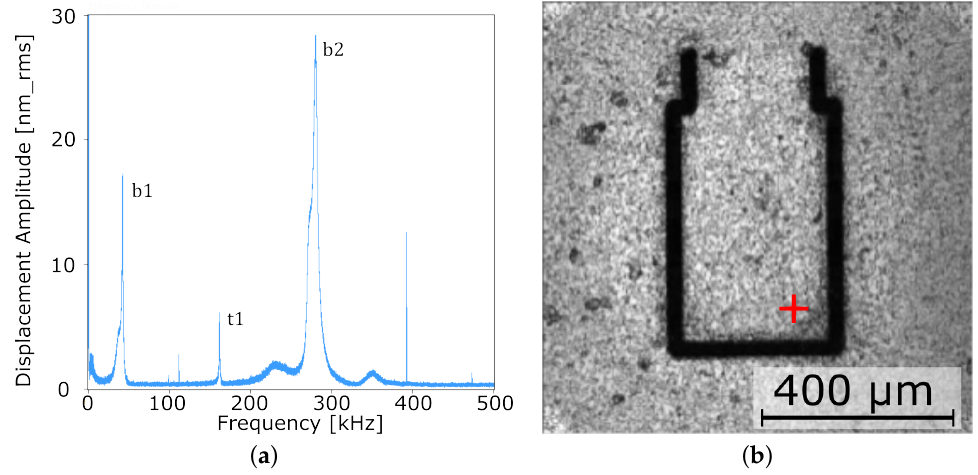
Figure 8. ( a ) Vibrational response of the micro cantilever measured at the location indicated by the red mark in the microscopy image ( b ). Peaks b1, b2, and t1 denote bending and torsional